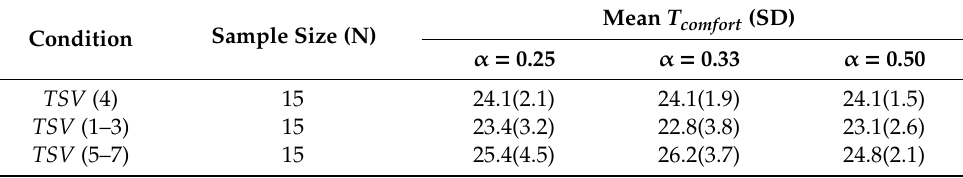
Table 3. Prediction of comfort sleep temperature by the Gri ffi ths